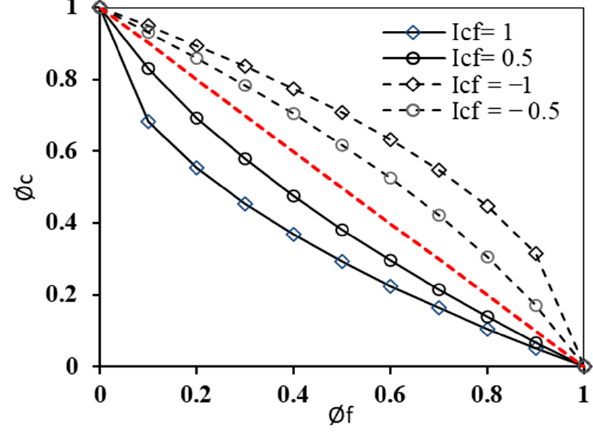
Figure 17. Parametric study of creep–fatigue damage interaction coefficient.